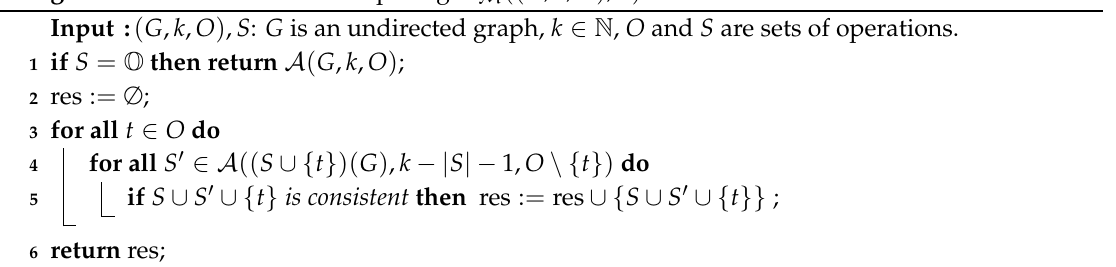
Algorithm 3: Procedure for computing N M (( G , k , O ) , S